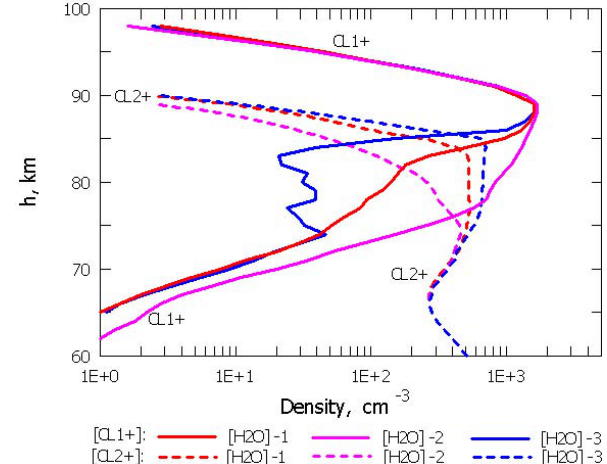
Fig. 7b. Number density profiles for the Cl + cluster families for 19 June 1969 at 15:00UT, with a solar zenith angle of 43.2 ◦ , F 10 . 7 = 149, and calculated for the H 2 O-1, H 2 O-2 and H 2 O-3 profiles.